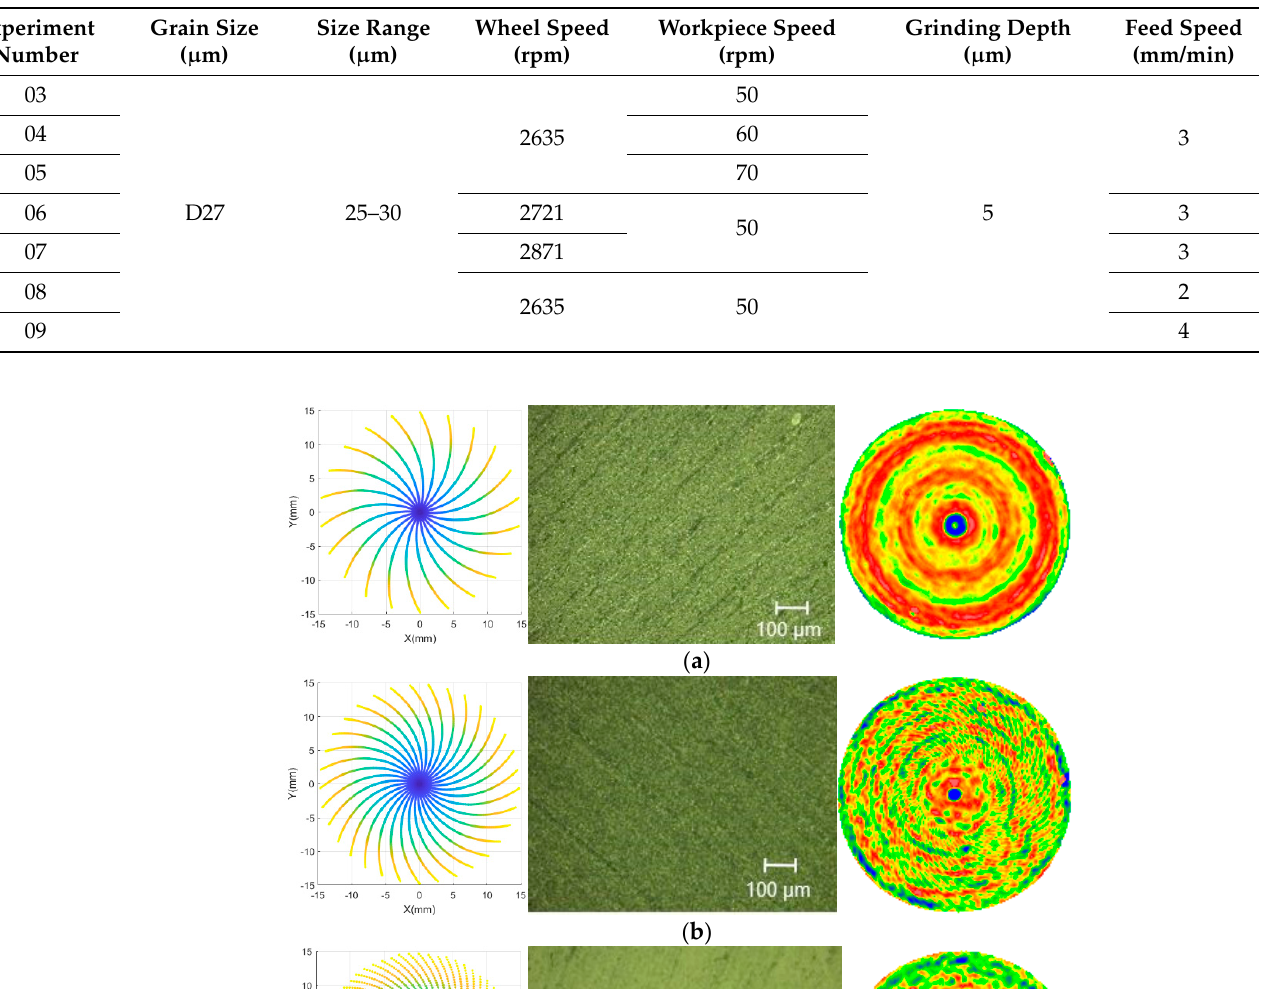
Table 1. Grinding conditions for single ‐ factor tests. Table 1. Cont.